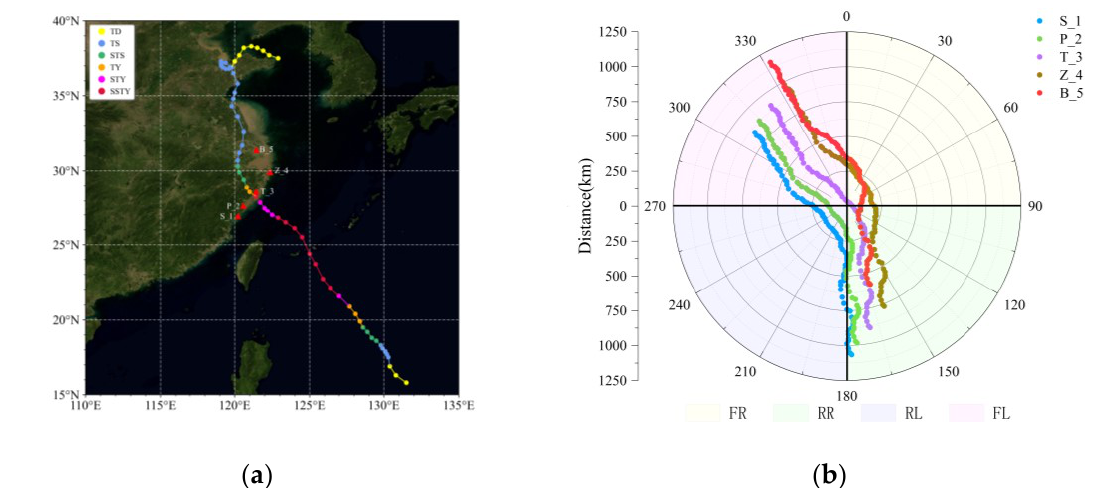
Figure 1. ( a ) Track and intensity of Super Typhoon Lekima and location of observation sites. (TD — Tropical Disturbance and Tropical Depression, TS — Tropical Storm, STS — Severe Tropical Storm, TY — Typhoon, STY — Severe Typhoon, and SSTY — Super Typhoon). ( b ) The azimuth and relative distance distribution of each DWL relative to the typhoon center. (Front left (FL), Front right (FR), Rear left (RL), Rear right (RR)).